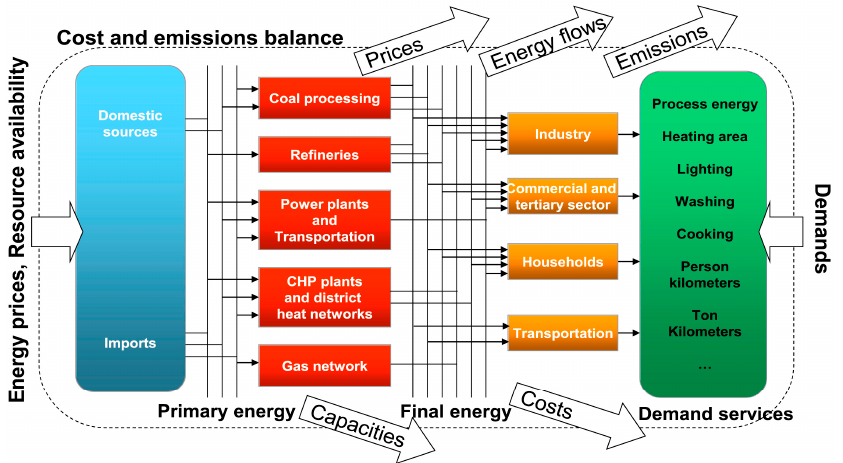
Figure 2. Energy system model TIAM scheme. Source: